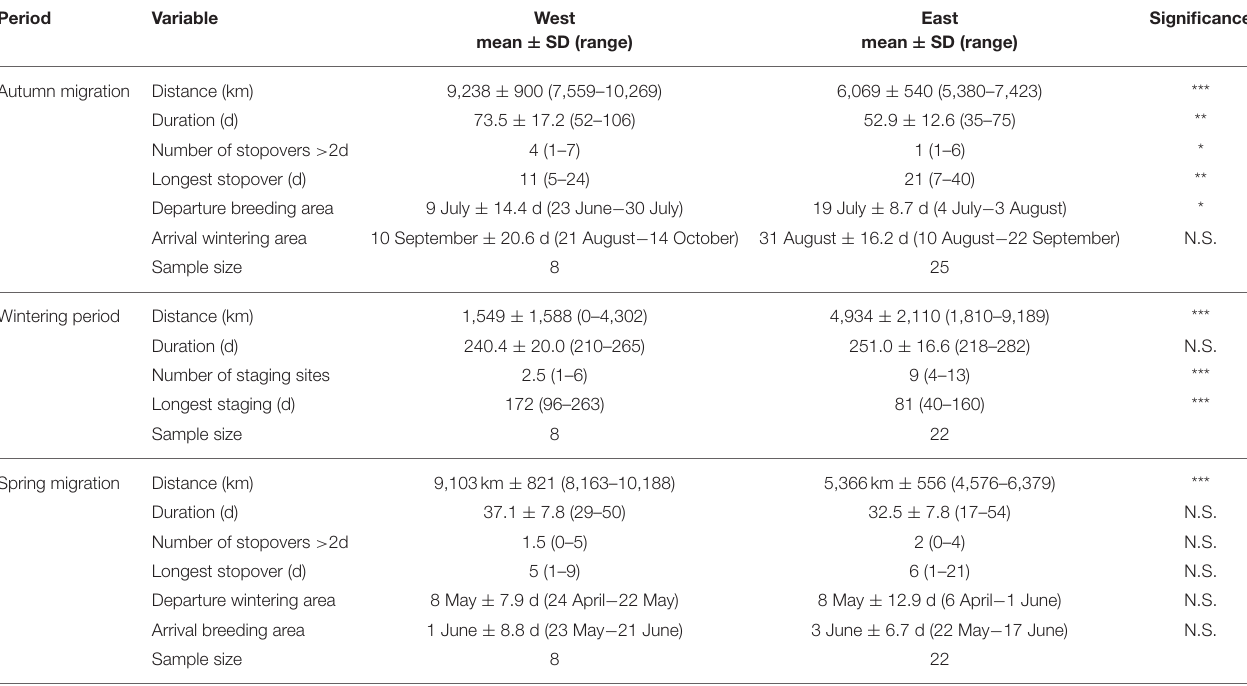
TABLE 1 | Characteristics of autumn and spring migration of red-necked phalaropes migrating between north-eastern North Atlantic breeding areas and the Pacific (“West”) and between Fennoscandian-Russian breeding areas and the Arabian Sea (“East”). Period Variable West East mean ± SD (range) mean ± SD (range)